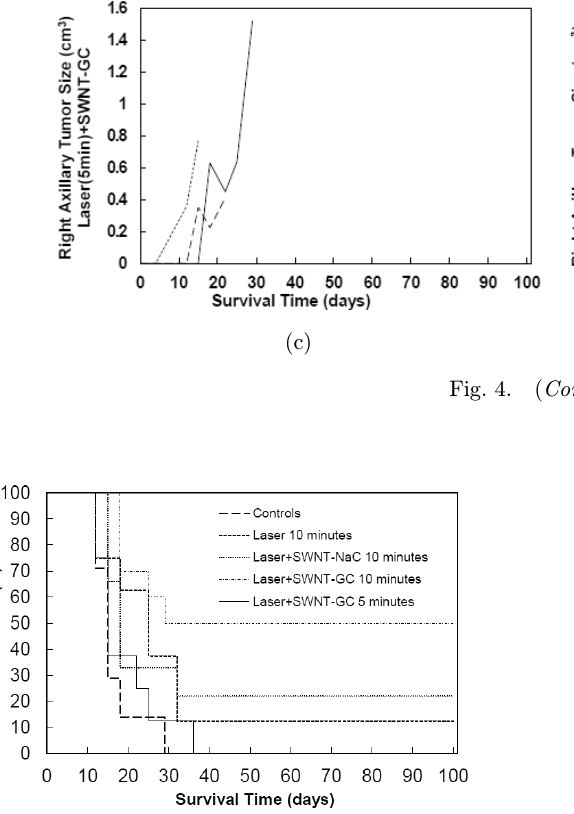
Fig. 5. Overall survival rates. Primary tumors in rats were treated 10 – 14 days after tumor inoculation, when tumor vol- ume was approximately 0.5 cm 3 . The treated rats were observed up to 100 days. Rats receiving Laser þ SWNT – GC for 10 min had a 50% long-term survival rate, rats receiving Laser þ SWNT – GC for 5 min had a 0% survival rate, rats receiving Laser þ SWNT – NaC for 10 min had a 22% long-term survival rate, and rats receiving laser only treatment for 10 min had a 12.5% long-term survival